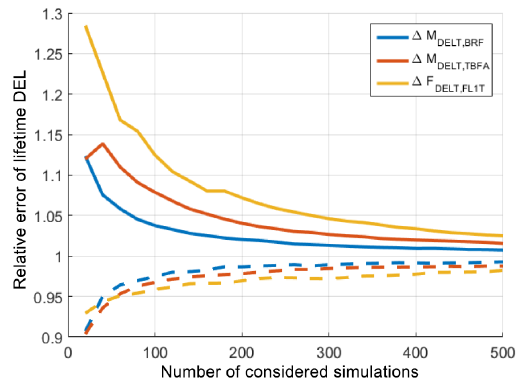
Figure 9. First percentile (dashed lines) and 99th percentile (straight lines) of the computed lifetime DEL for different load lo- cations as a function of considered samples and simulations. Results are normalized with the resulting value based on 5400